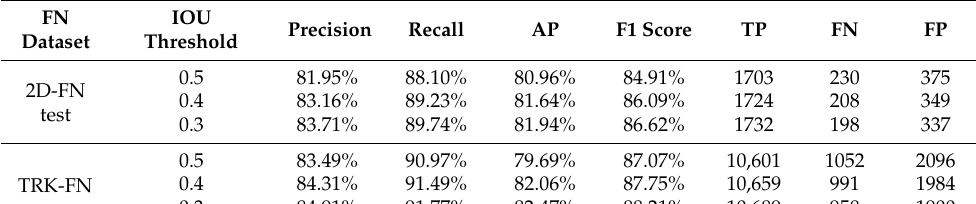
Table 1. Bounding box level FN prediction accuracy.